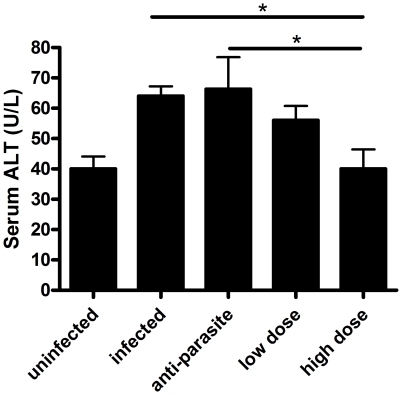
Anti-fibrosis treatment with prizaquantel reduced serum alanine aminotransferase (ALT) level in mice 15 weeks post infection with Schistosoma japonicum.Serum ALT was assessed by Olympus AU5400 automatic biochemistry analyzer. Levels of serum ALT were significantly decreased nearly to the normal level after anti-fibrosis treatment with high dose prizaquantel. (* p<0.05).